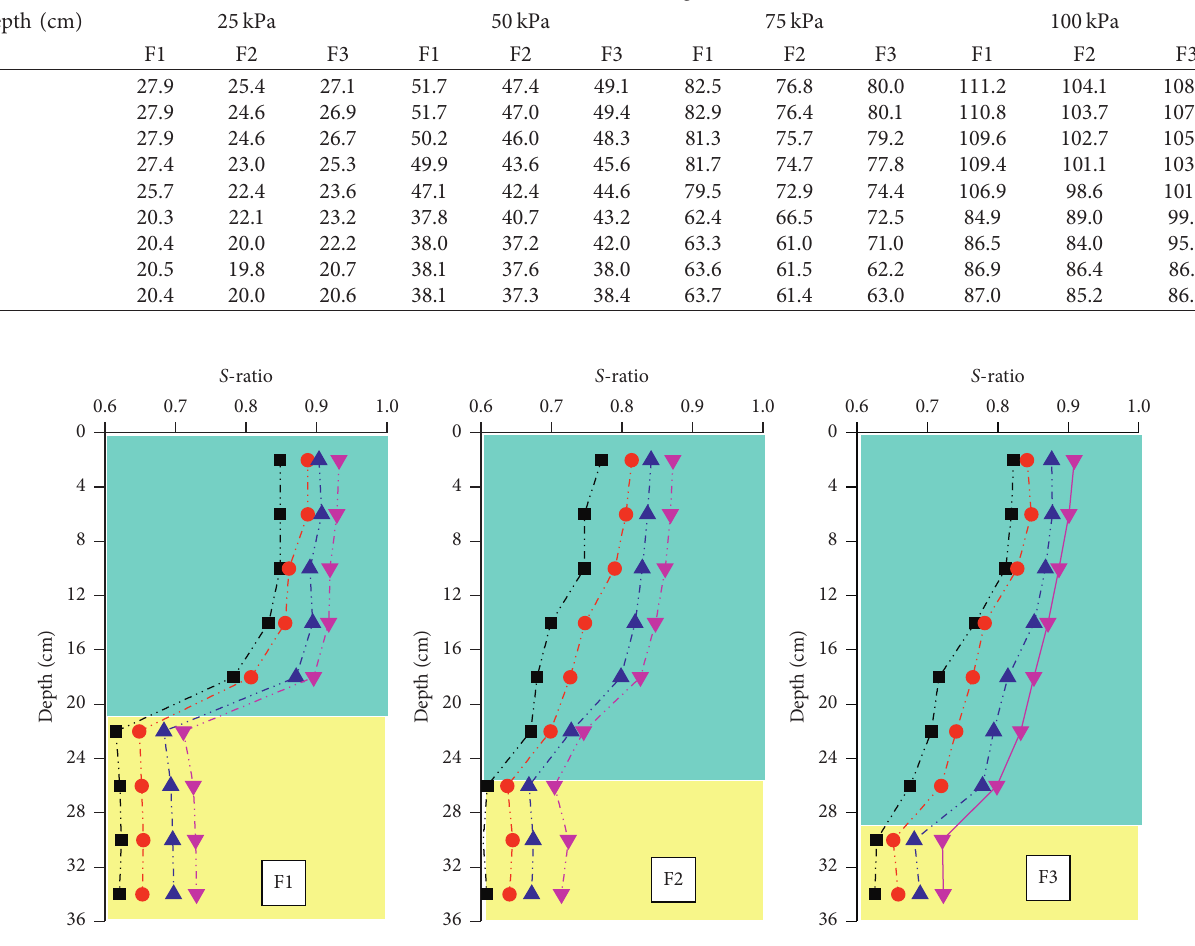
Table 4: Shear strength of expansive soil columns at different depths under different normal stress after the freeze-thaw process. Shear strength (kPa) Depth (cm) 25kPa